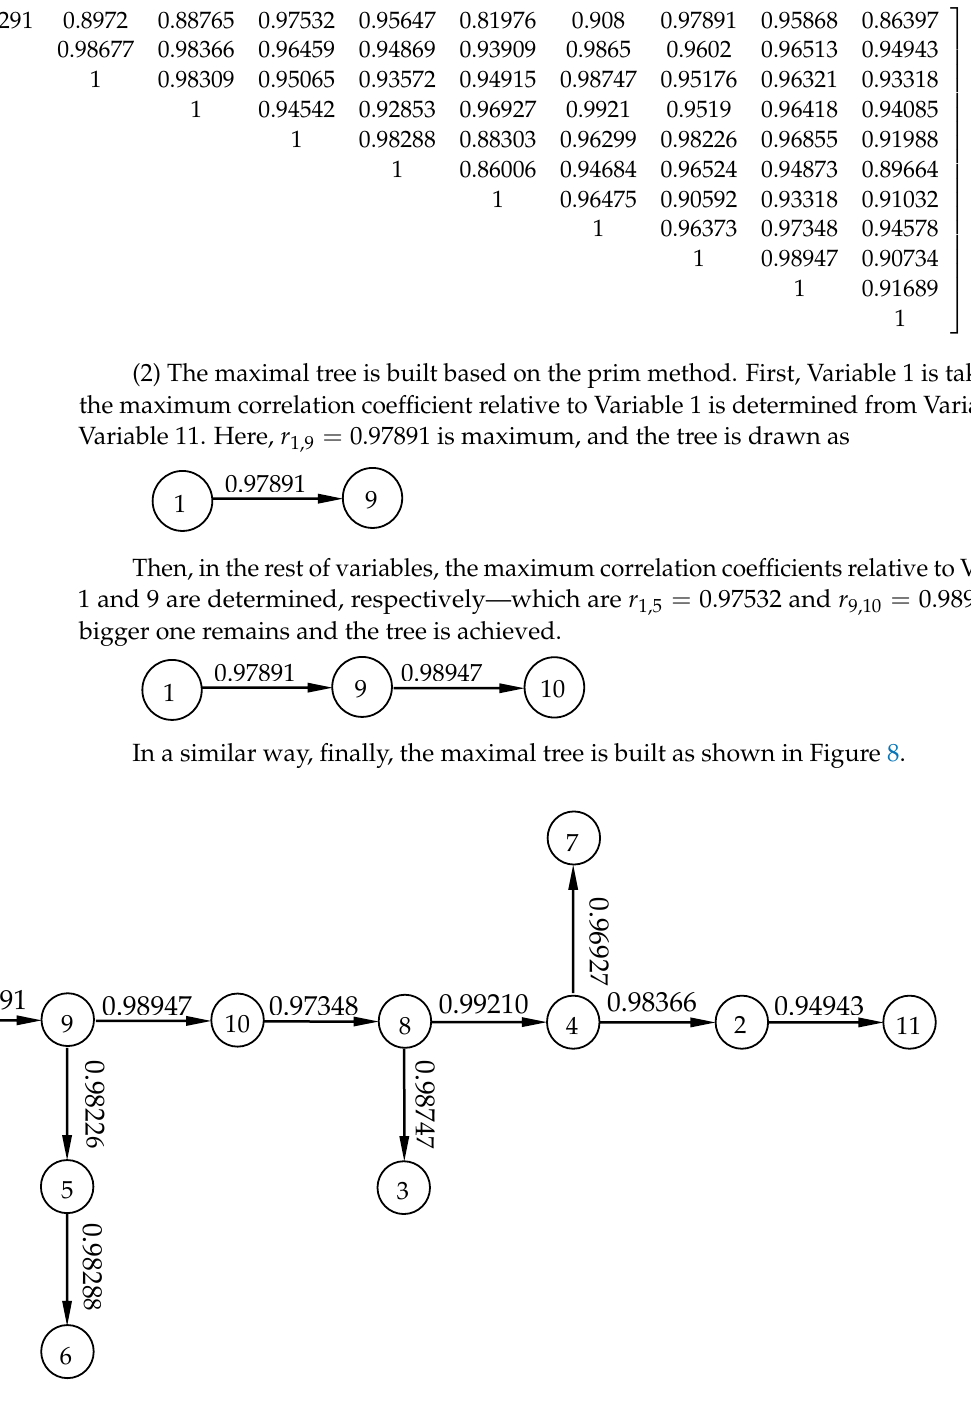
Figure 8. The maximal tree of the clustering analysis of the maximal tree method. (3) Clustering analysis was conducted. When λ is in [0,1], the branches of the maximal tree whose correlation coefficients are less than λ are cut off, and a disconnected graph was obtained. The connected branches are the cluster results based on the threshold value . The cluster results can be seen in Table 3.